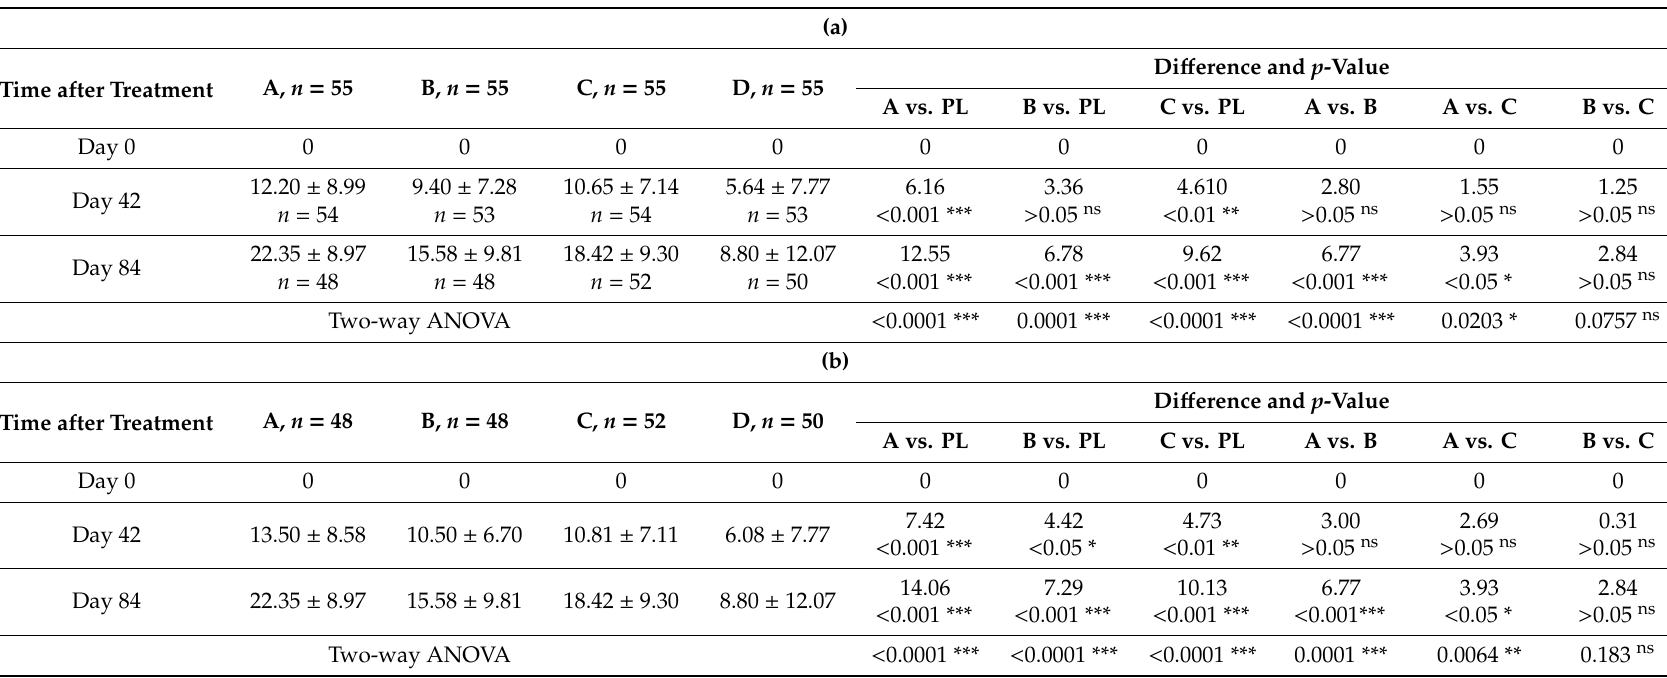
Table A2. ( a ). The change from baseline of KMI (mean ± SD) over time. All patients including dropouts—ITT analysis. ( b ). The change from baseline of KMI (mean ± SD) over time. Patients completed the treatment and all tests, dropouts excluded—PP